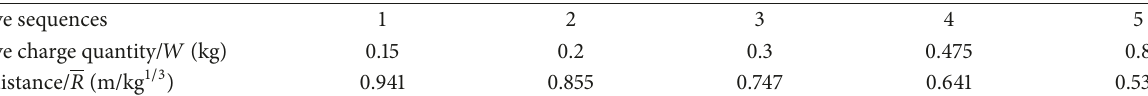
Table 4: Test conditions of the internal explosion.